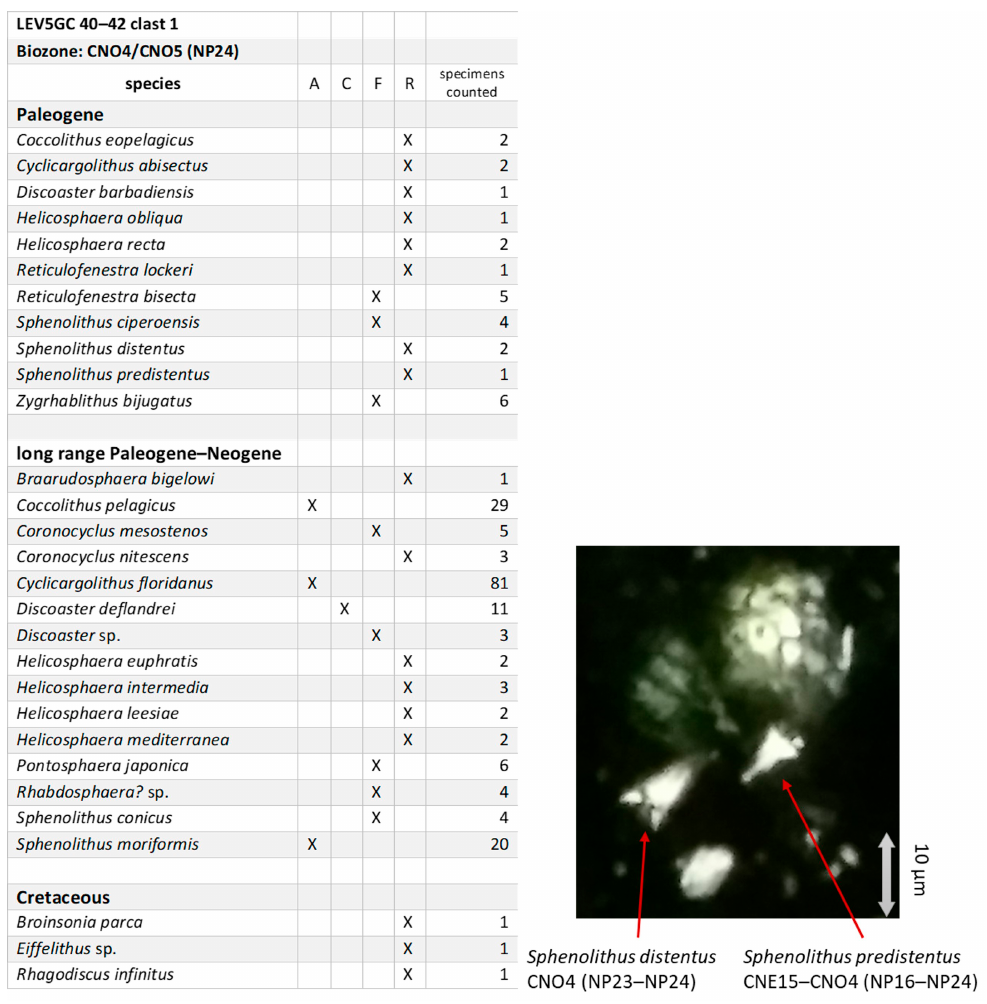
Figure 5. Example of an age-diagnostic assemblage list showing the relative abundances of the nannofossil species in the total assemblage of the LEV5GC 40–42 clast 1 sample. The coexistence of Sphenolithus distentus and Sphenolithus predistentus (their microscopic image appears at the right) and Sphenolithus ciperoensis defines the CNO4/CNO5 biozone. The identified Cretaceous species along with some Paleogene (pre-Oligocene) species are considered as reworked.